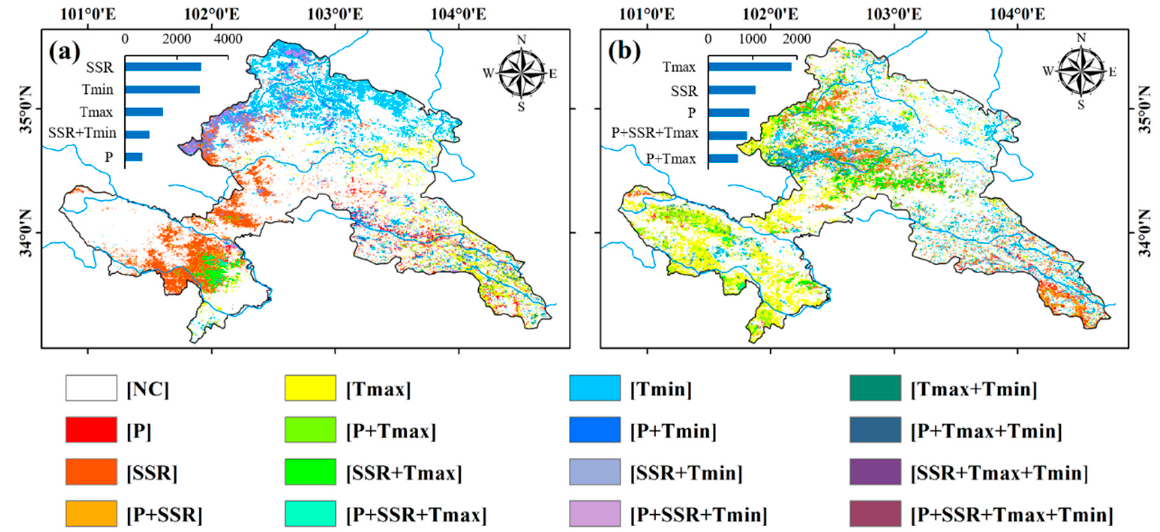
Figure 11. Significance-based diagnosis of the relationship between LSSP and key climatic factors and their combinations on the SGP. Subplots ( a , b ) correspond to SD and SCD, respectively. Histograms in the left corners show the top five areas influenced (km 2 ) and NC indicates an area that failed the significance test.